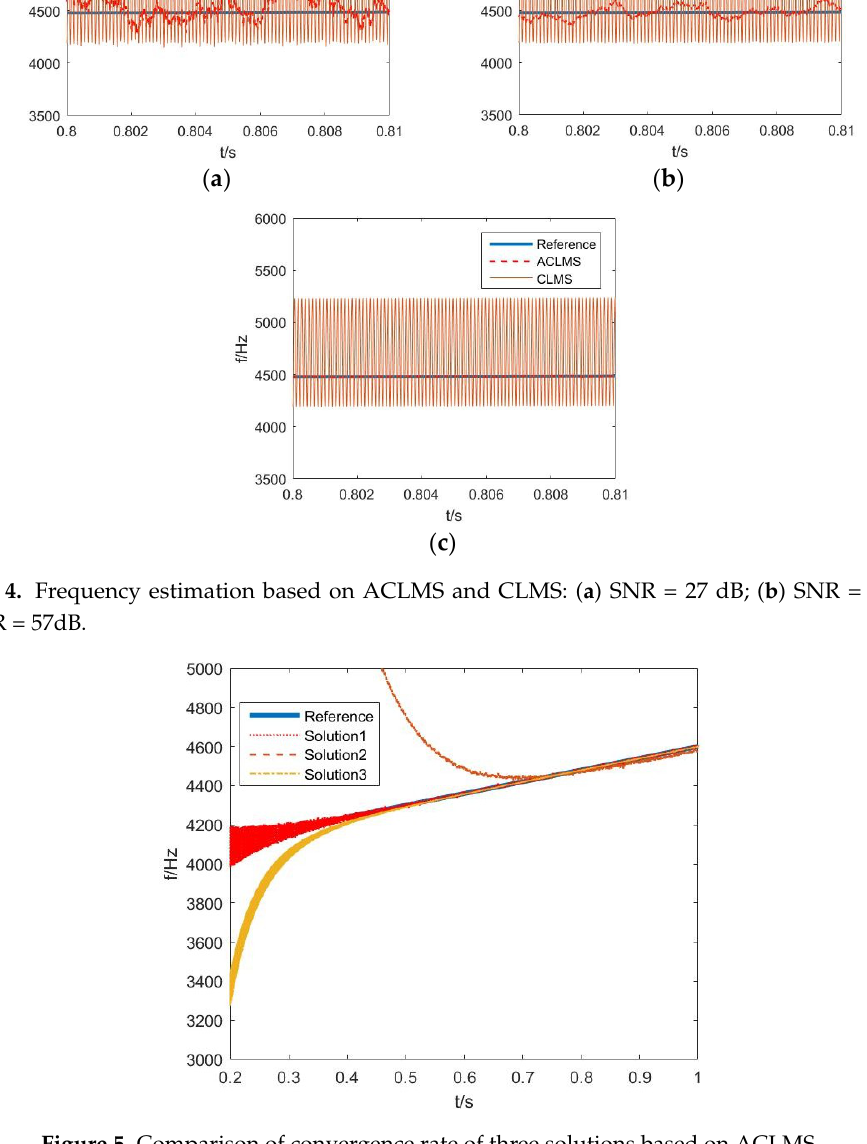
Figure 5. Comparison of convergence rate of three solutions based on ACLMS.